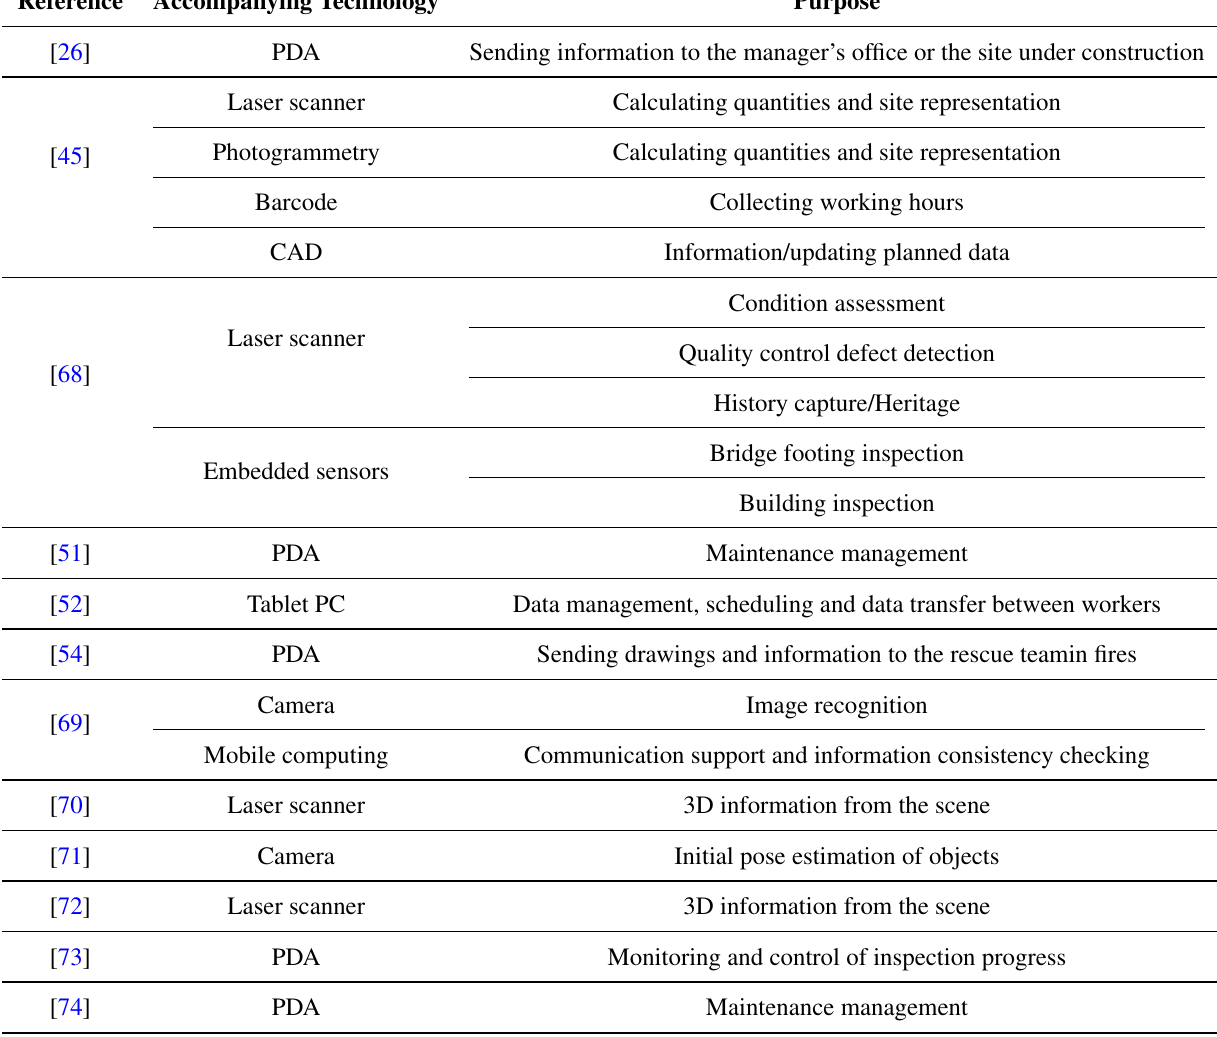
Table 8. Characteristics of different combinations of